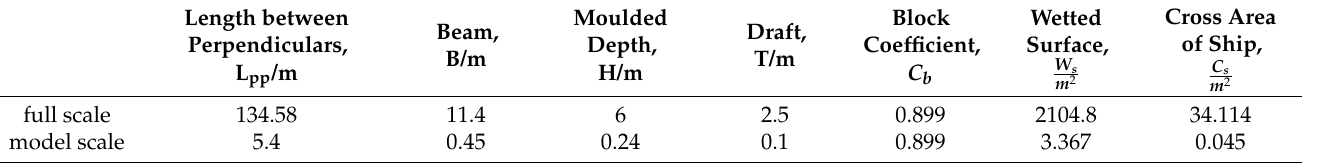
Table 1. Main parameters of the inland